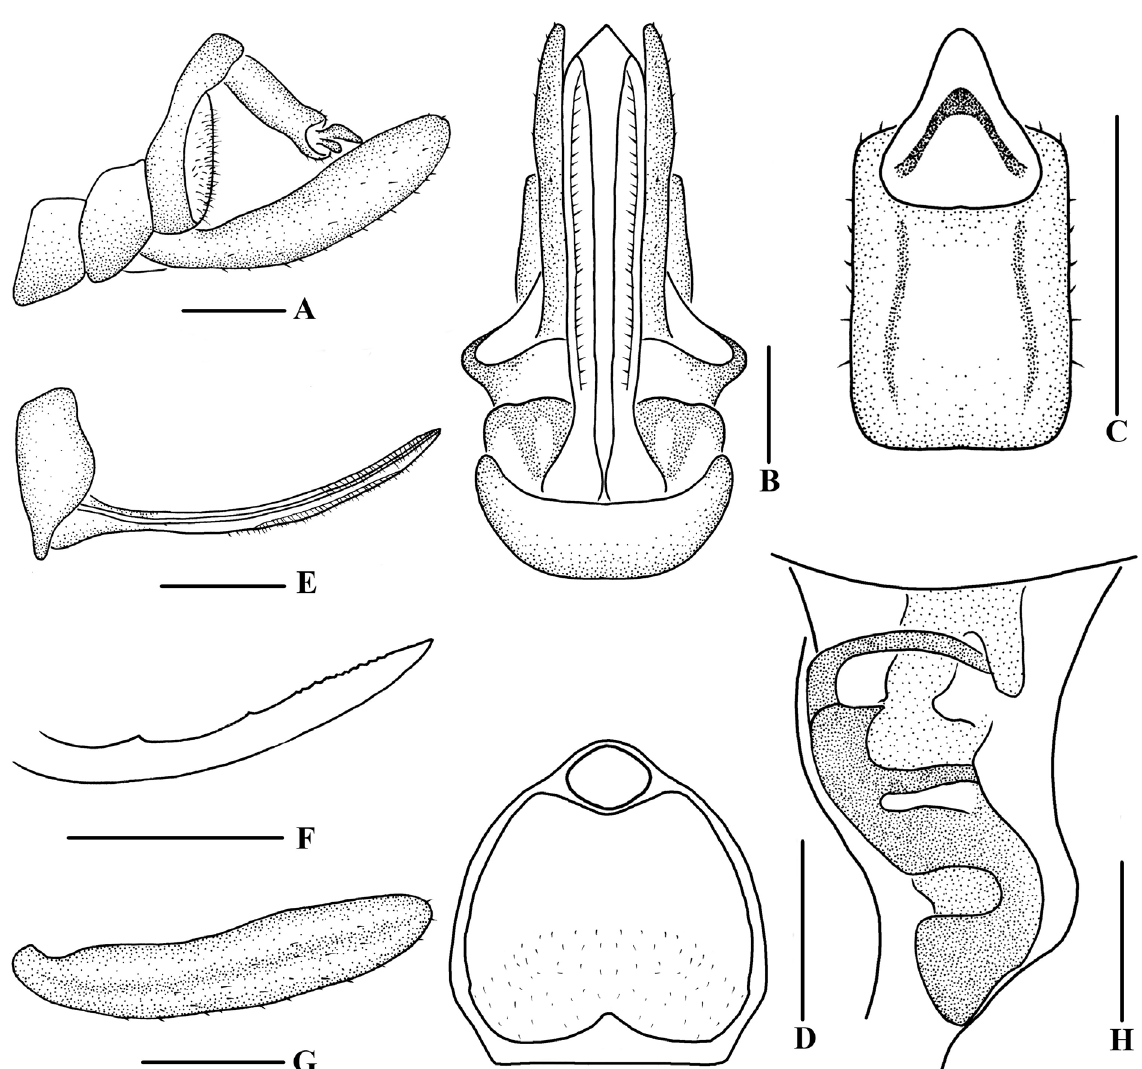
Fig. 2. Andes balteiformis Wang, Zhi & Chen sp. nov., ♀. A . Genitalia, lateral view. B . Genitalia, ventral view. C . Anal segment, dorsal view. D . Tergite IX, caudal view. E . Gonapophysis VIII and gonocoxa VIII, dorsal view. F . Gonapophysis IX, lateral view. G . Gonoplac, inner lateral view. H . Posterior vagina, ventral view. Scale bars: 0.5